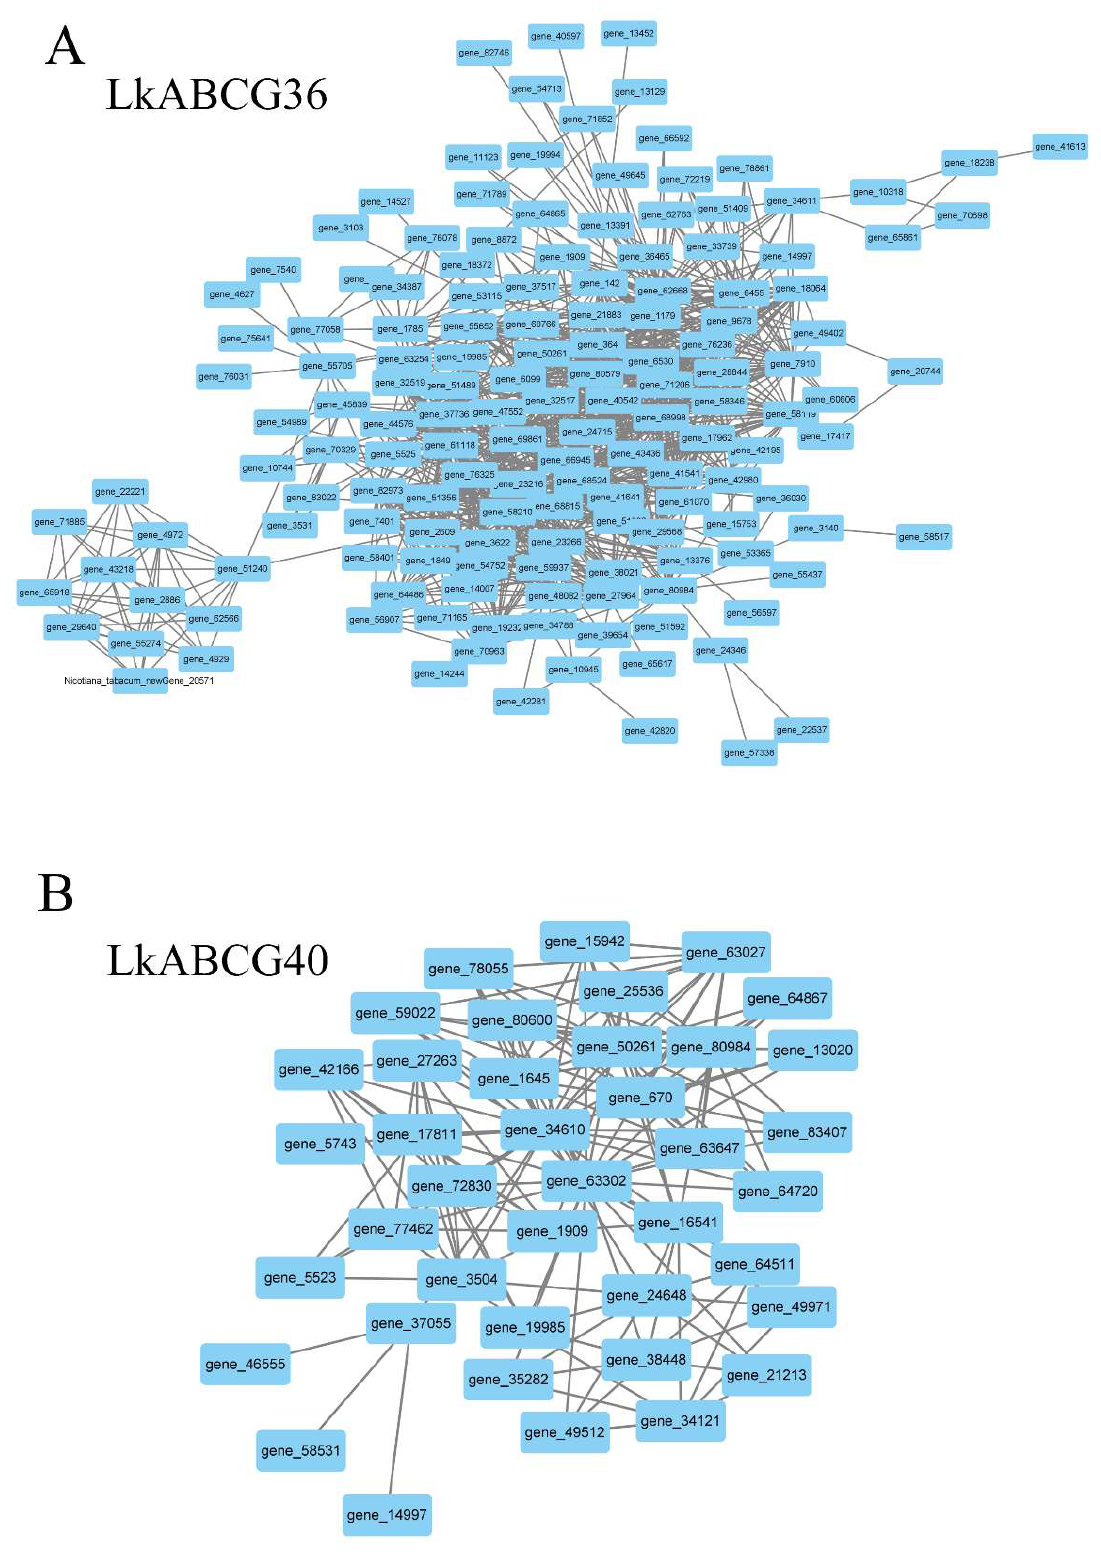
Figure 3. Characterization of DEGs in LkABCG36 and LkABCG40 groups. ( A ) Co-expression net- work analysis of DEGs in LkABCG36 group; ( B ) Co-expression network analysis of DEGs in LkA- BCG40 group.